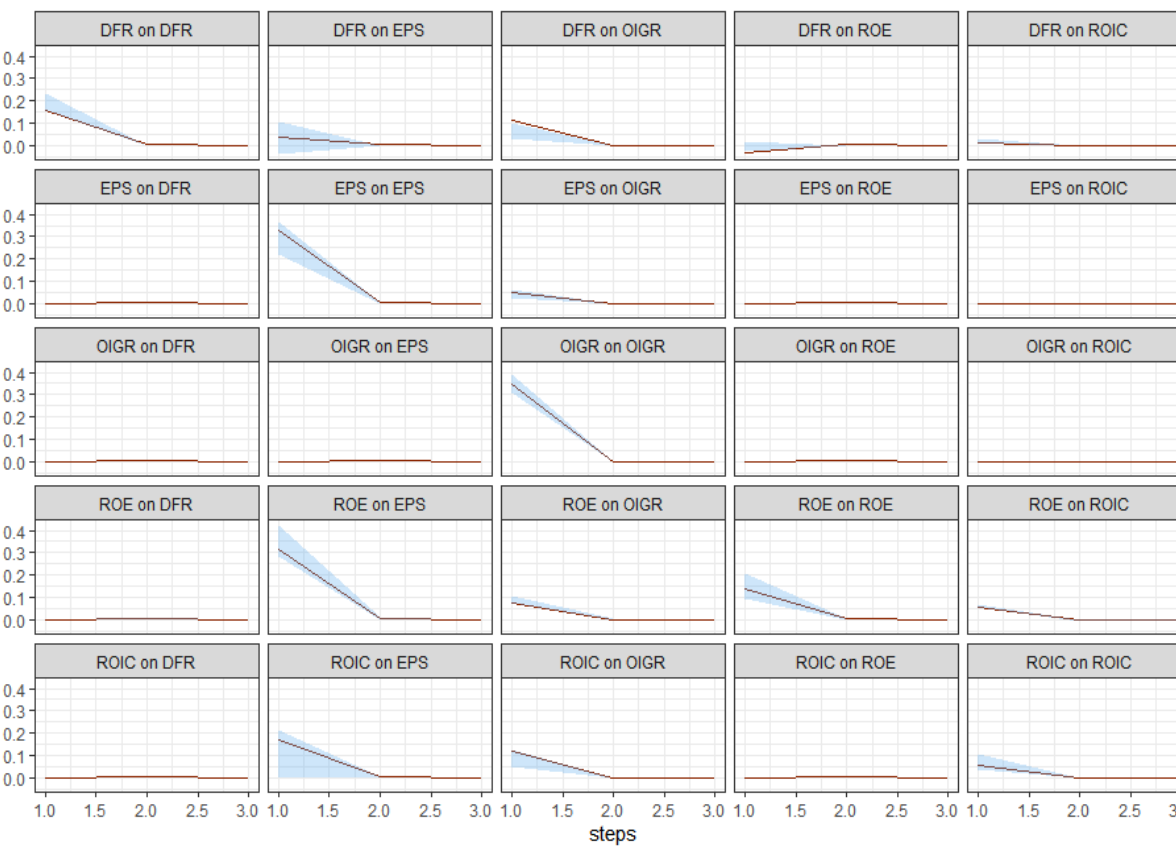
Figure 2. Impulse Response Function of model 1.